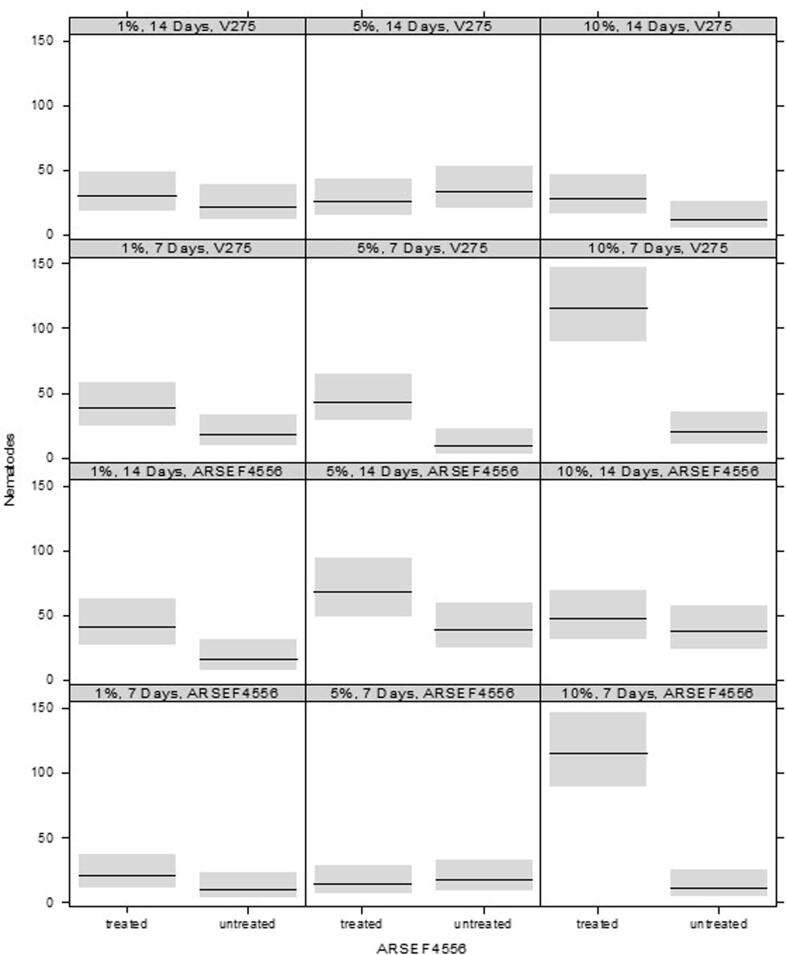
Numbers of nematodes attracted to either plants treated with Metarhizium or untreated plants. Midlines show median responses, with boxes spanning the interquartile ran.